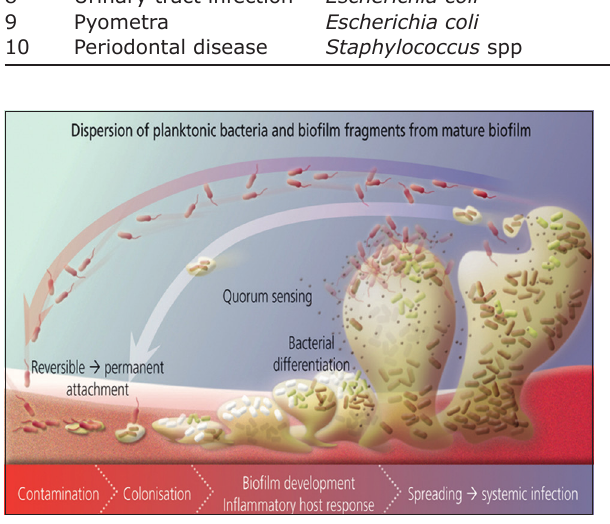
Figure-1: Sourced from Wikimedia: Schematic representation of polymicrobial biofilm